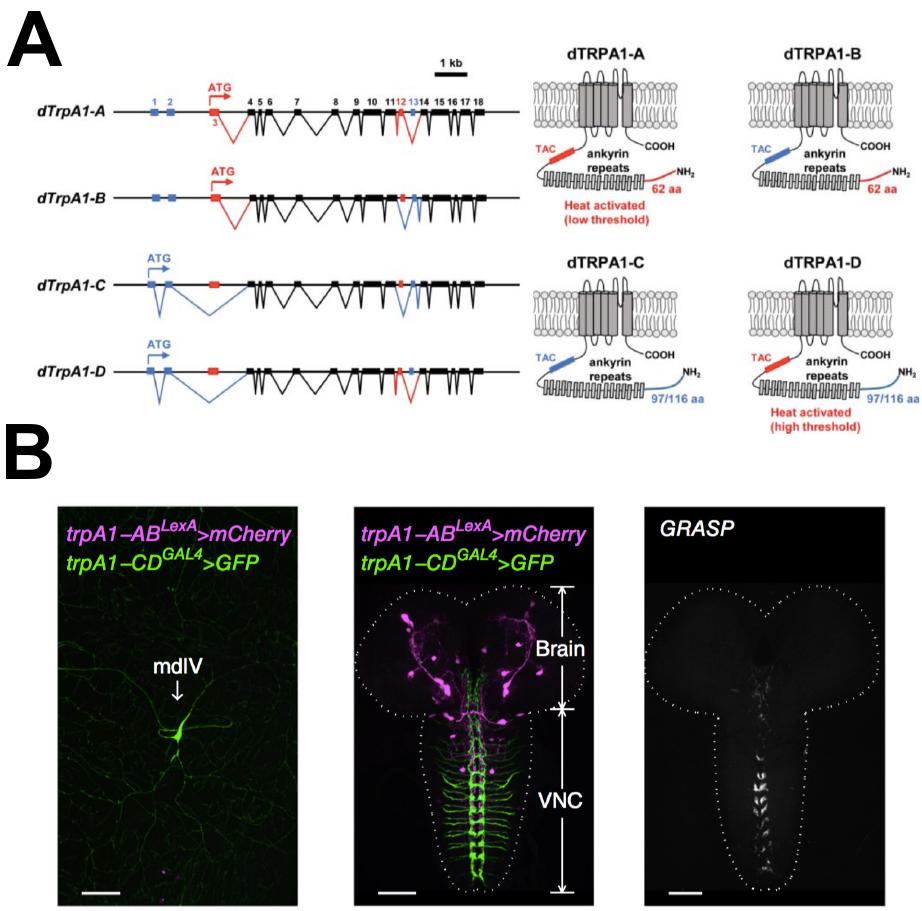
Figure 1. TRPA1 isoforms and their expression pattern in larvae. Taken from [11,15]. ( A ) gene and protein structures of the four TRPA1 isoforms [15]. trpA1 gene structures with exon numbering are shown on the left. The four isoforms originate from the use of an alternative translational start site (isoforms A/B use ATG in exon 3, red; isoforms C/D use ATG in exon 1, blue) and alternative splicing of exon 12 (included in isoforms A/D, red) and 13 (included in isoforms B/C, blue). TRPA1 protein structures are shown on the right. N-terminal region encoded by exon 3 is drawn in red (A/B), N-terminal region encoded by exon 1–2 is drawn in blue (C/D). TRP ankyrin cap (TAC) region between ankyrin repeats and first transmembrane domain encoded by exon 12 is drawn in red (A/D), the TAC region encoded by exon 13 is drawn in blue (B/C). Presumably, TAC is the element that confers temperature sensitivity to isoforms A/D, whilst the N-terminal region affects their activation threshold and responsiveness to the rate of temperature change [7,11]; ( B ) trpA1-CD GAL4 - and trpA1-AB LexA -expressing neurons are distinct cell populations that possibly form synapses in the ventral nerve cord (VNC) and may function in a common neuronal circuit [11]. The trpA1-CD GAL4 reporter is expressed in multidendritic neurons (md neurons) in the larvae body wall, while trpA1-AB LexA is expressed in the larval brain and VNC. Green Fluorescent Protein reconstitution across synaptic partners (GRASP) signal indicates that the two cell populations are in close proximity in the